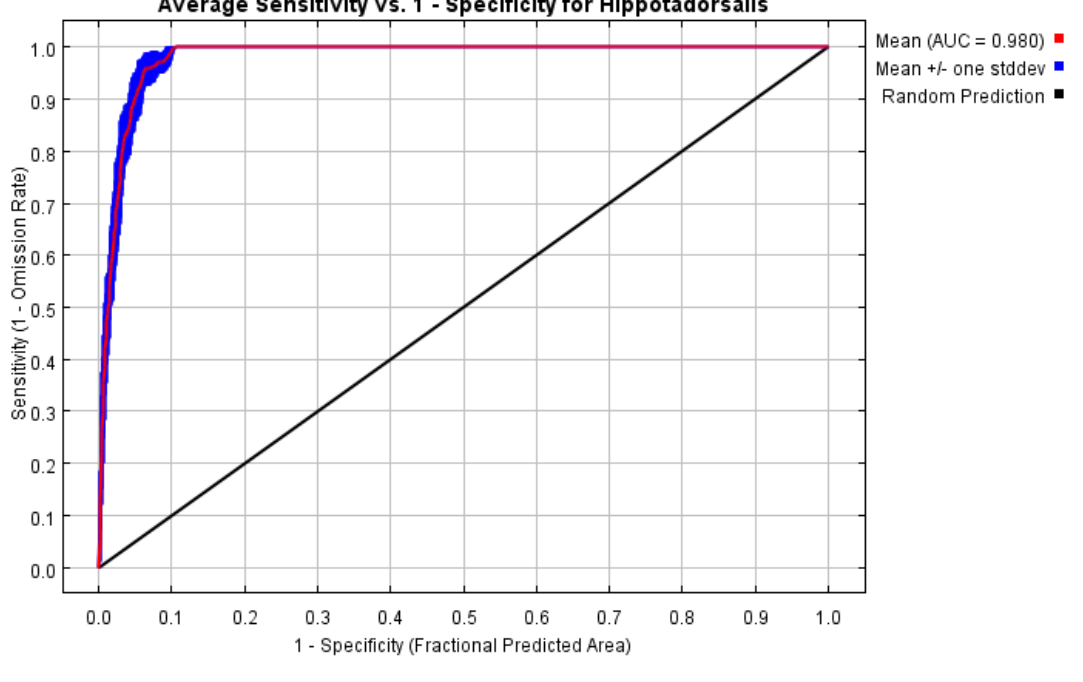
Figure 5. AUC value of test on applicability of the MaxEnt